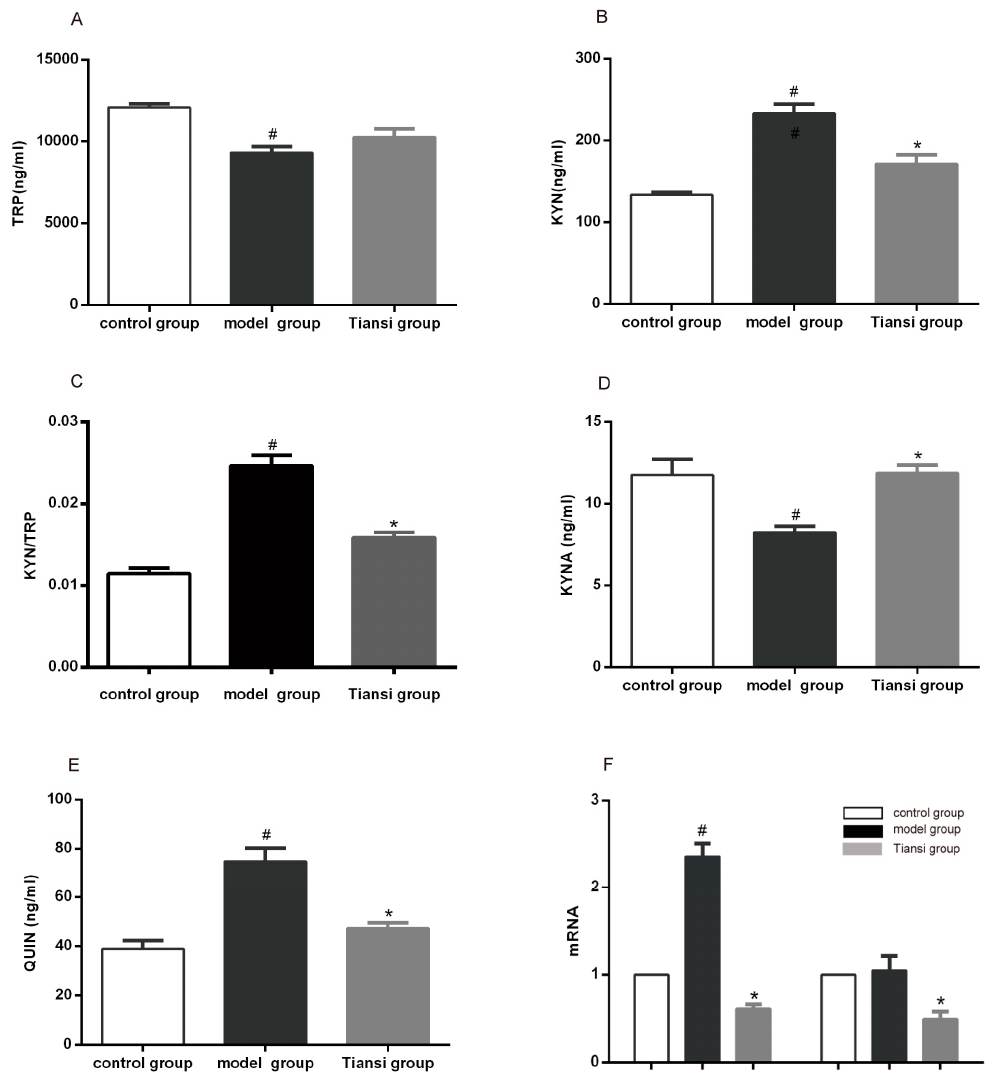
Figure 2. Effects of Tiansi Liquid on TRP–KYN metabolites. Effects of Tiansi Liquid treatment on TRP ( A ), KYN ( B ), KYN/TRP ratio ( C ), KYNA ( D ) and QUIN ( E ). Effect of Tiansi Liquid treatment on